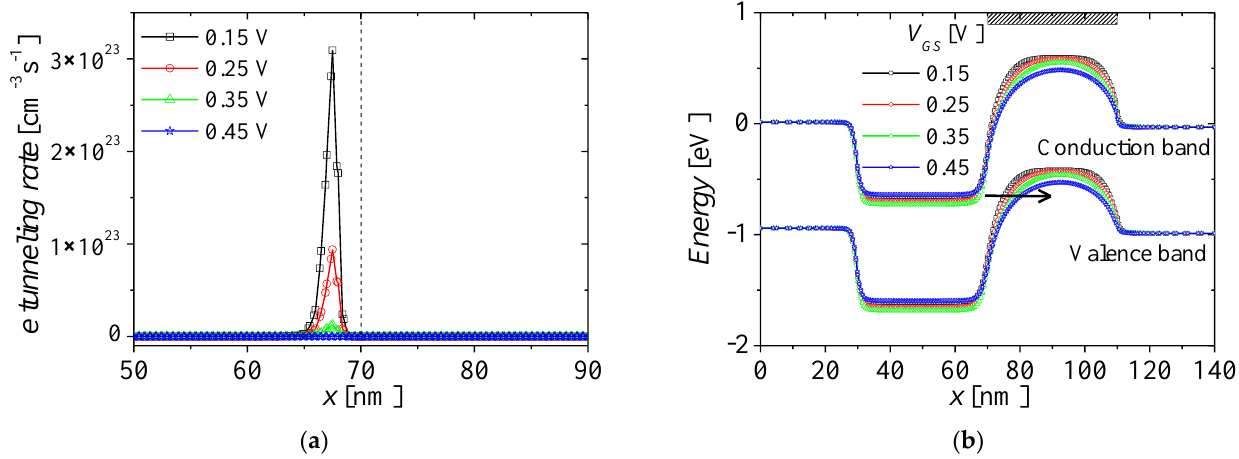
Figure 8. ( a ) Electron tunneling rates and ( b ) energy bands on surface region at V GS = 0.15 (black), 0.25 (red), 0.35 (green), and 0.45 V (blue) at V DS = 1 V. Figure 9a,b show the carrier concentrations on surface region at V GS = 0.35 and 0.45 V when BTBT is considered and ignored. The red and black lines denote electron and hole concentrations, respectively, and the solid and dash lines denote electron and hole concentrations with BTBT and non-BTBT, respectively. As shown in Figure 9a, carrier concentrations considering BTBT at V GS = 0.35 V are still some different from those ignoring BTBT, owing to remaining of BTBT at the surface. However, there is no longer a difference between carrier concentrations considering and ignoring BTBT when BTBT disappear at V GS = 0.45 V, as shown in Figure 9b. Therefore, as V GS increases, the current decreases, as shown in Figure 4. When V GS > 0.45 V, the current considering and ignoring BTBT are the same since BTBT does not exist, as shown in Figure 4.